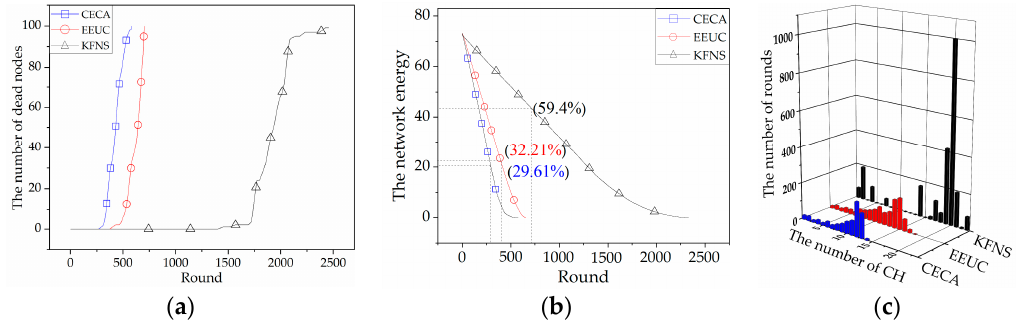
Figure 8. ( a ) The curves of dead node number by rounds; ( b ) network energy consumption; ( c ) number of cluster heads and boundary nodes.